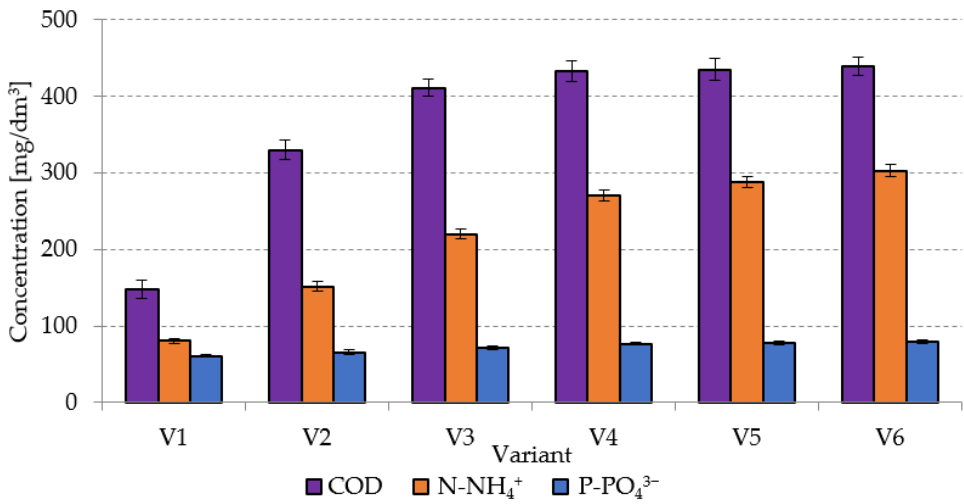
Figure 1. Changes in concentrations of organic compounds and nutrients in AGS supernatant caused by the pretreatment with SCO 2 .